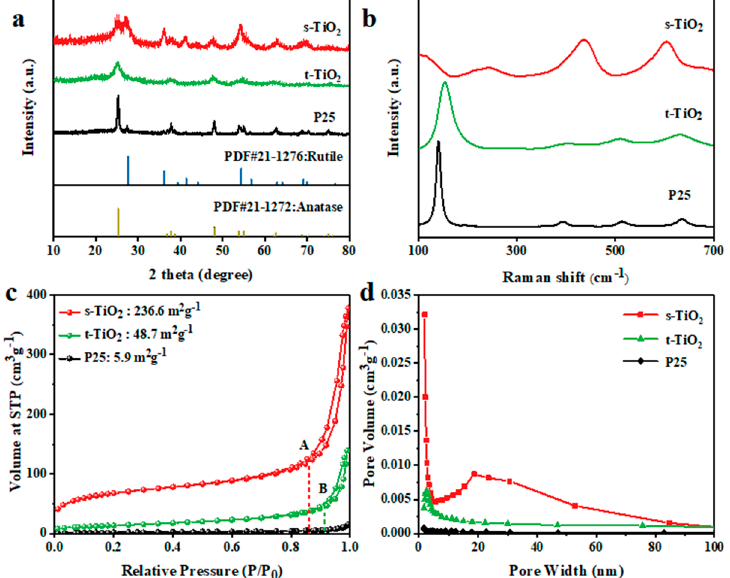
Figure 1. ( a ) XRD patterns, ( b ) Raman spectra, ( c ) BET spectrum, and ( d ) pore size distribution of s-TiO 2 , t-TiO 2 , and P25.